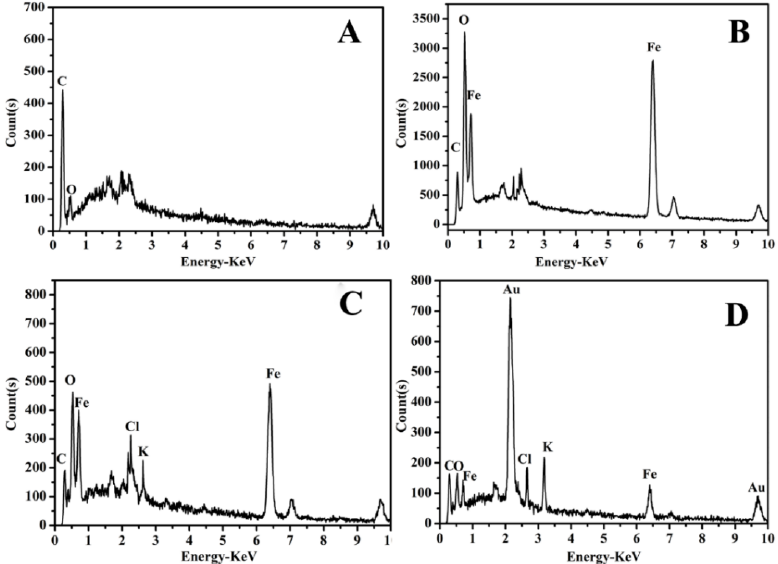
Figure 5. EDS spectra of bare SPE ( A ), GO/Fe 3 O 4 ( B ), GO/Fe 3 O 4 /PB ( C ), and GO/Fe 3 O 4 /PB@Au ( D ).